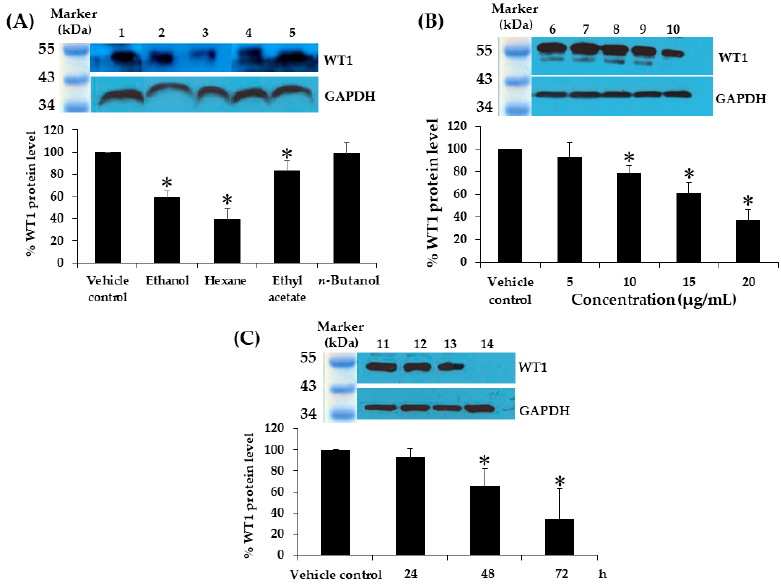
Figure 3. E ff ects of ka ffi r lime leaf extracts on WT1 protein levels in K562 cells. ( A ) WT1 and glyceraldehyde 3-phosphate dehydrogenase (GAPDH) proteins following the treatment of (No. 1) 0.18% DMSO (vehicle control) and (No. 2) ethanol, (No. 3) hexane, (No. 4) ethyl acetate, and (No. 5) n -butanol extracts at IC 20 for 48 h. ( B ) K562 cells grown in a medium with (No.6) 0.08% DMSO (vehicle control), and (No. 7) 5 µ g / mL, (No. 8) 10 µ g / mL, (No. 9) 15 µ g / mL, and (No. 10) 20 µ g / mL of hexane extract for 2 days. ( C ) K562 cells treated with (No.11) 0.05% DMSO (vehicle control) for 3 days and 13.6 µ g / mL of hexane extract for 24 h (No. 12), 48 h (No. 13), and 72 h (No. 14). WT1 and GAPDH protein levels were determined using the Western blot analysis. WT1 (48–54 kDa) and GAPDH (37 kDa) bands were quantified using a densitometer. WT1 protein levels were measured and normalized using GAPDH protein level. Data are expressed as mean ± SD of three independent experiments. Asterisk (*) demonstrates statistically significant di ff erence between the values of the vehicle control and the sample ( p <